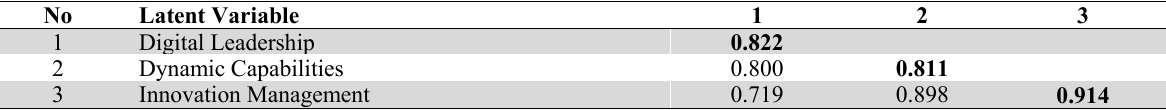
Discriminant Validity